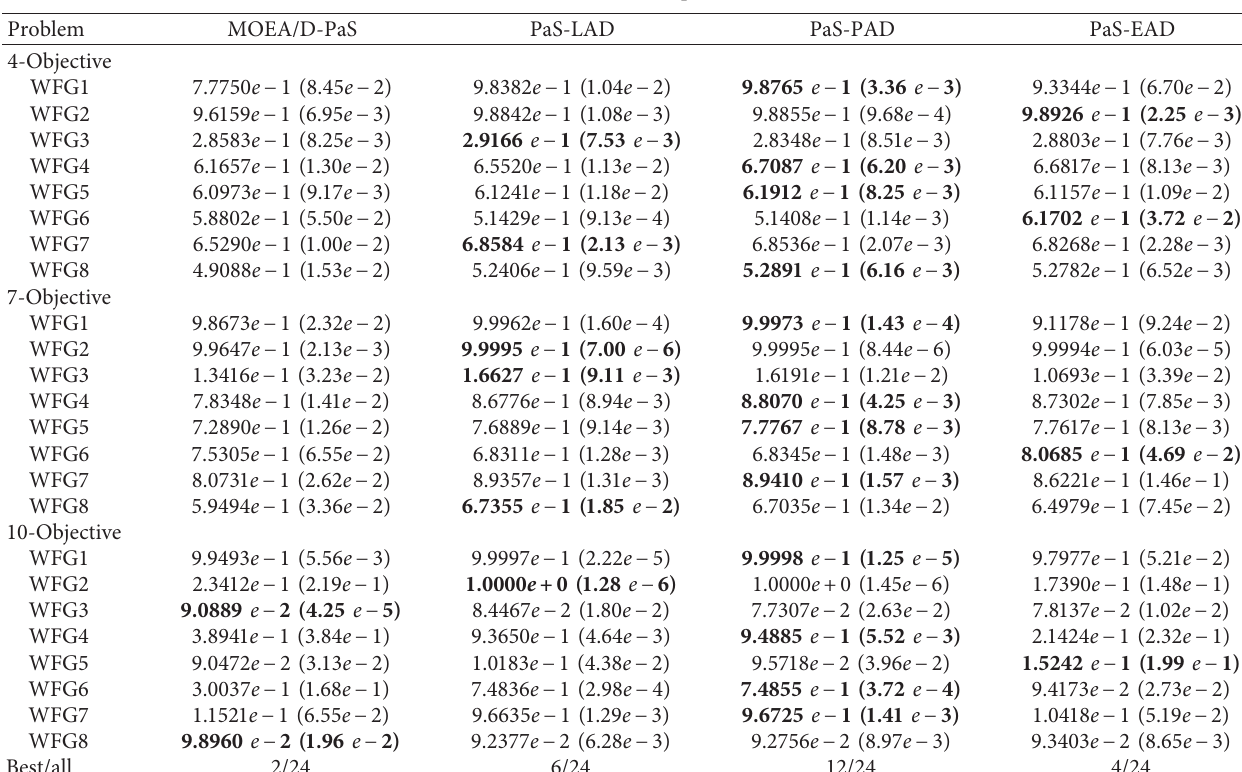
Table 4: HV metric (mean/std) comparison results on